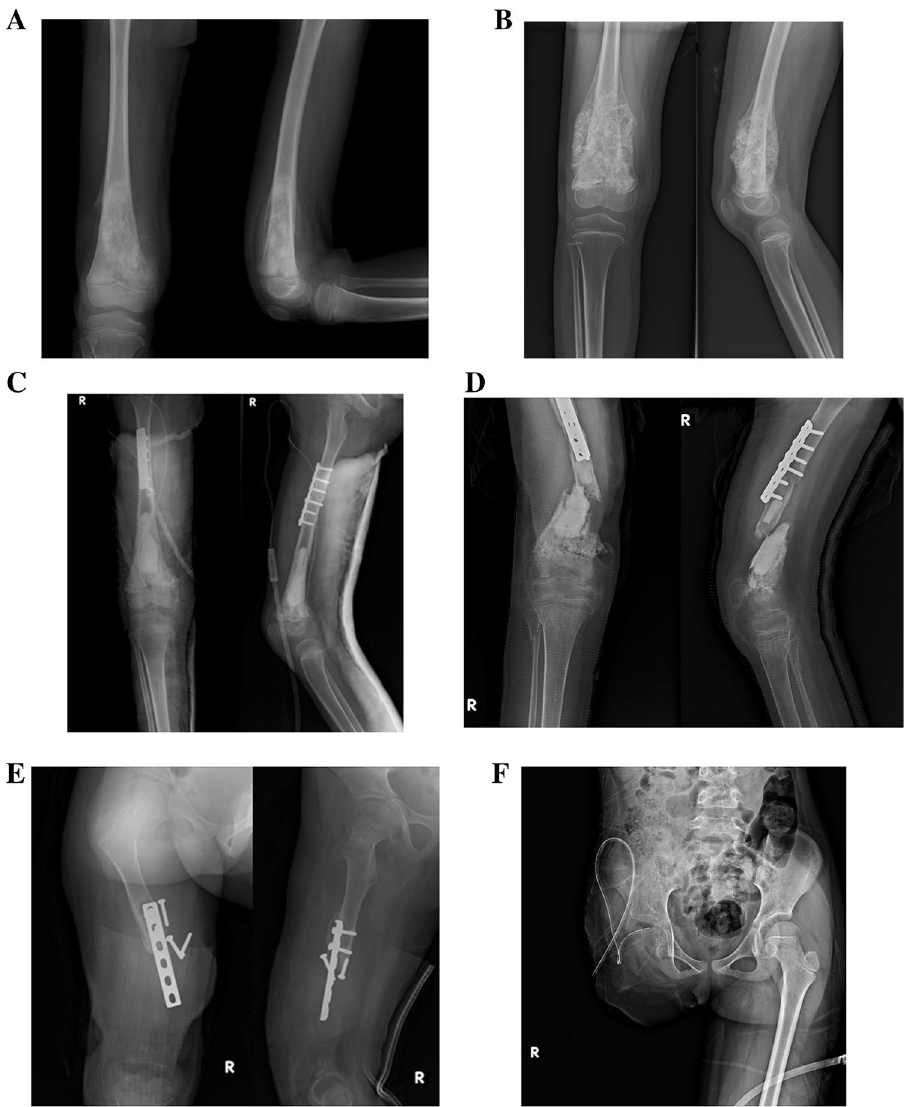
Figure 3. A 6-year-old girl with conventional osteosarcoma of the right distal femur. ( A ) Preoperative anteroposterior and lateral radiograph. ( B ) After chemotherapy, an osteoblastic lesion of the distal femur was observed. ( C ) Wide resection and reconstruction with recycled frozen autograft were performed. ( D ) Fracture of the graft occurred 1 year after surgery. ( E ) Lysis of the graft was found 15 months later. ( F ) Finally, hip disarticulation was